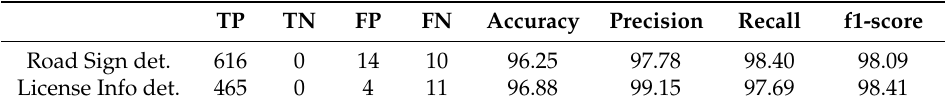
Table 1. Metrics for the performance results of the three modules. TP TN FP FN Accuracy Precision Recall f1-score Road Sign det. 616 0 14 96.25 465